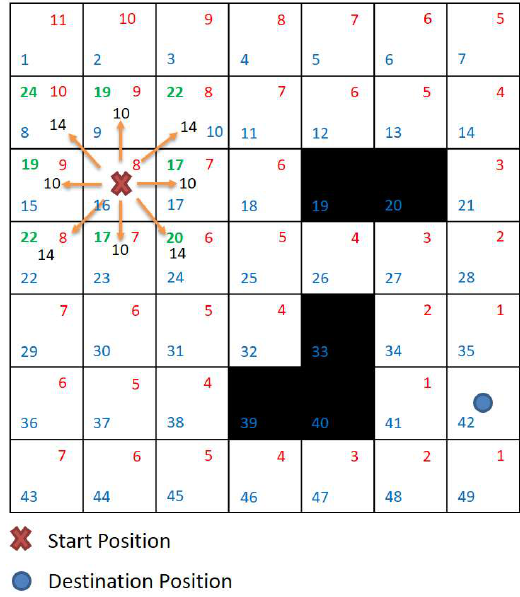
Figure 9. A* algorithm.